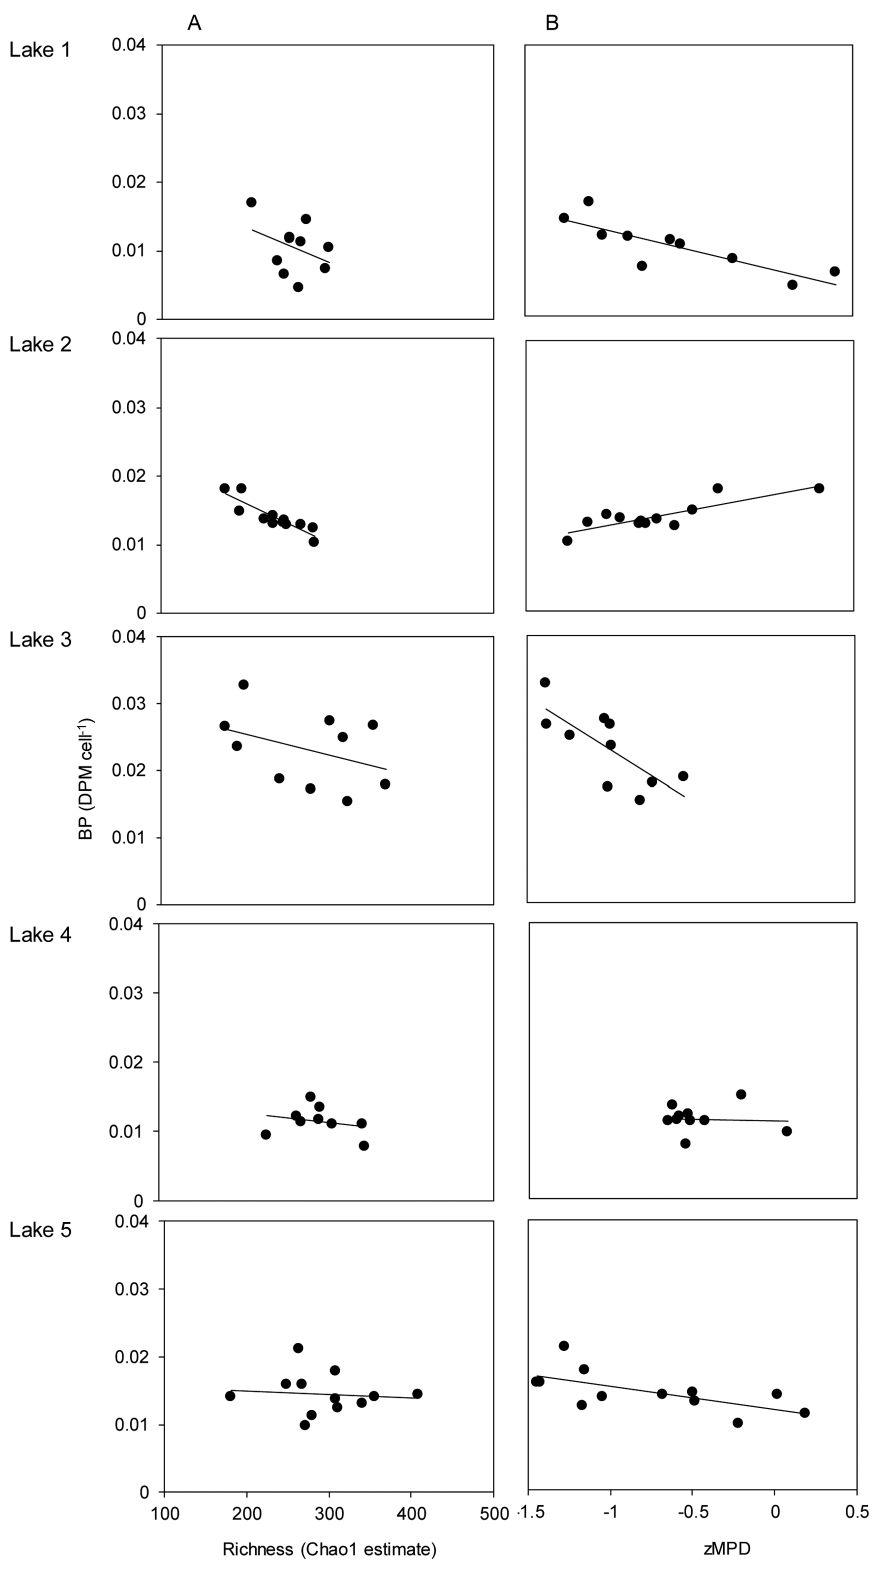
Figure 2. Associations between functioning and richness (A), and functioning and average phylogenetic distance (B). Community functioning is assessed as per cell bacterial production, local richness of the bacterial community estimated by Chao1 (A), and average phylogenetic distance between bacteria in a community estimated as standardized effect size of MPD (B).